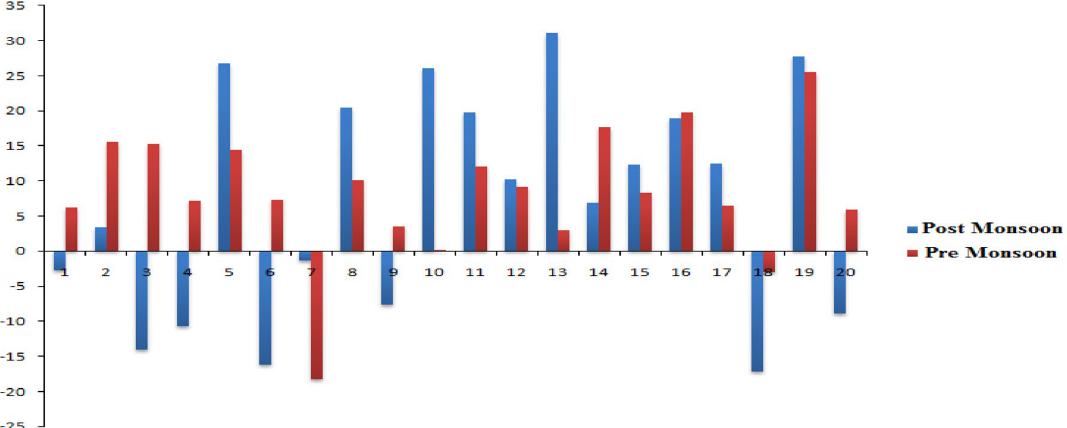
Fig. 8 Ion balance